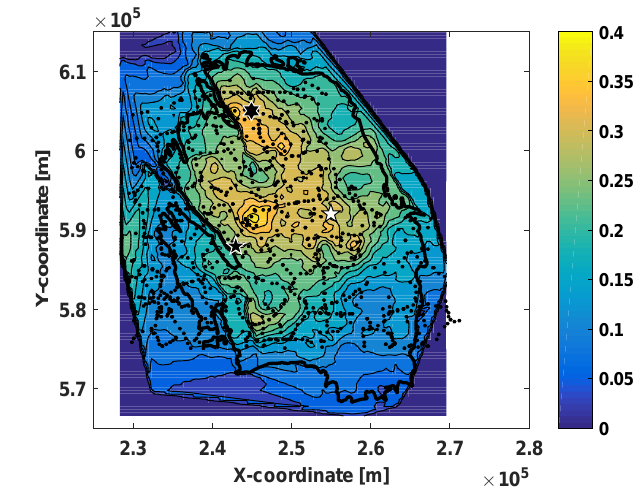
Figure 1. Prior estimate of the compaction field of the Groningen gas field in 2013 (color-coded), outline of the gas-bearing layers (solid line) and surface locations of the benchmarks used in the study (filled